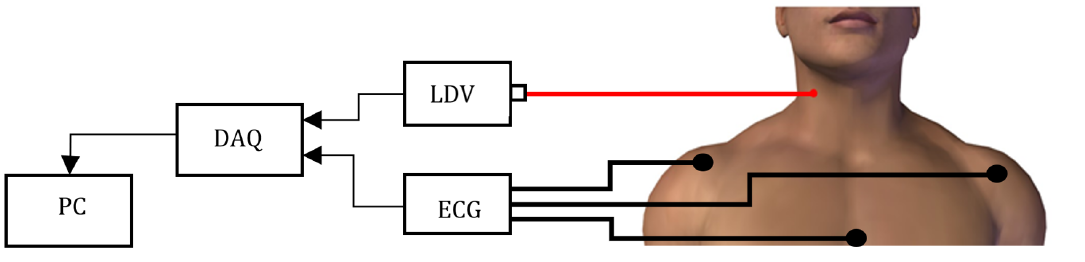
Figure 1. The LDV measurement set-up is composed by a Laser Doppler Vibrometer (LDV) pointed on the subject’s skin over the carotid. The LDV signal is generated and fed to a PC by a DAQ